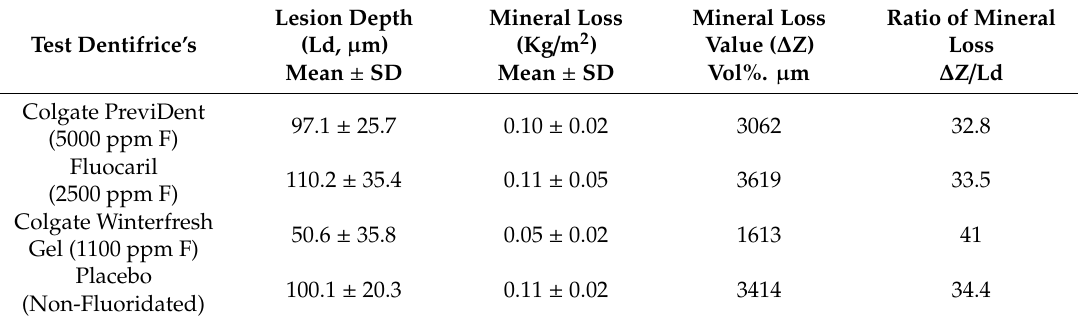
Table 2. Transversal microradiography data for the enamel.